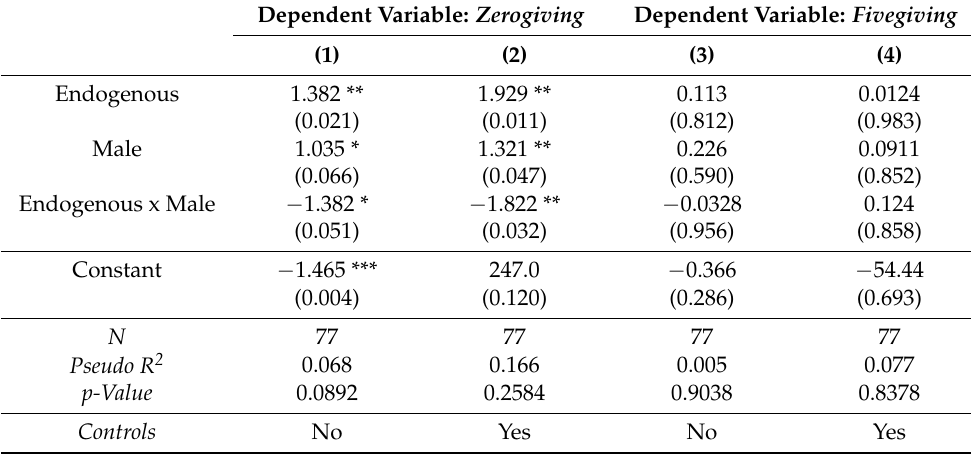
Table A1. Probit regression results for dictator games. Dependent Variable: Zerogiving Dependent Variable: